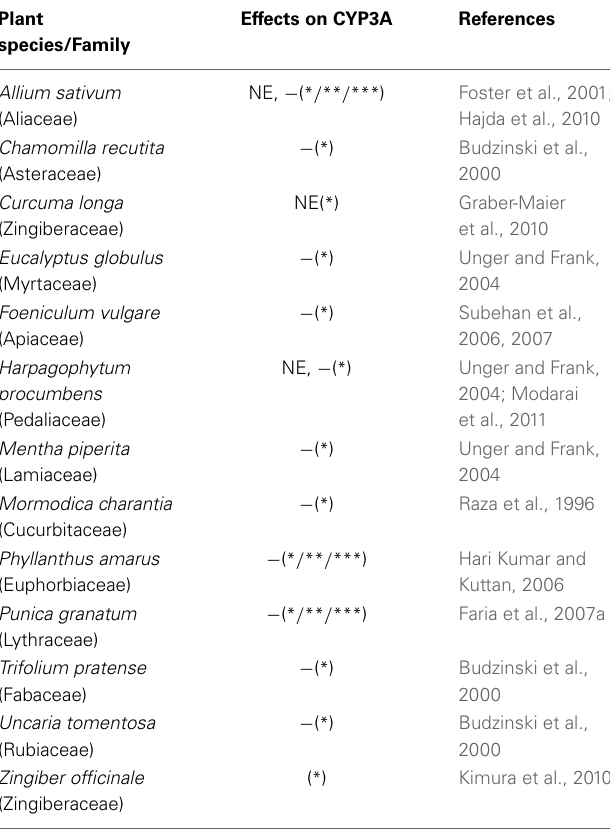
Table 6 | Medicinal plant species listed in RENISUS with reported effects of on